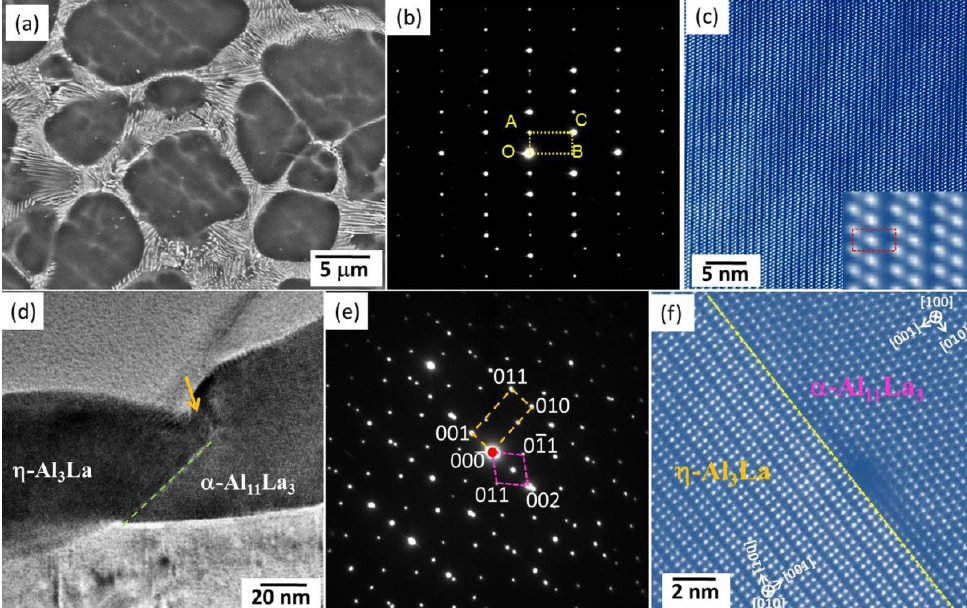
Figure 5. ( a ) SEM image; ( b ) SAED pattern; ( c ) atomic resolution HAADF-STEM image of the new phase in ALaM440 alloy; ( d ) TEM image; ( e ) SAED pattern; ( f ) atomic resolution HAADF-STEM image of the coexistence of η-Al 3 La and Al 11 La 3 [66,123].